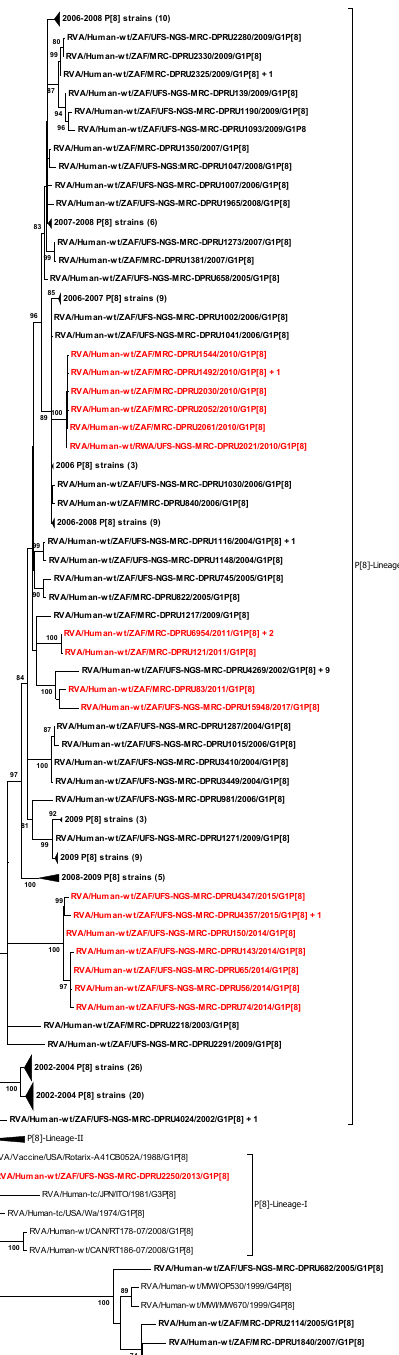
7 of 20 The VP4 phylogenetic tree comprised nucleotide sequences of the South African RVA strains